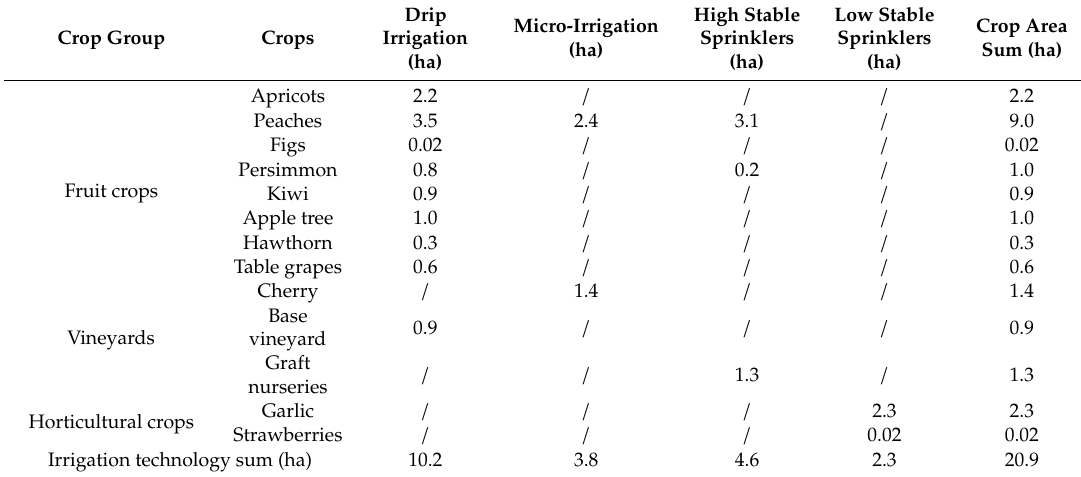
Table A1. Crops included in the irrigation-decision support system (IDSS) experimental implementation by area (ha) and irrigation technology (drip irrigation, micro-irrigation, high stable sprinklers, low stable sprinklers).